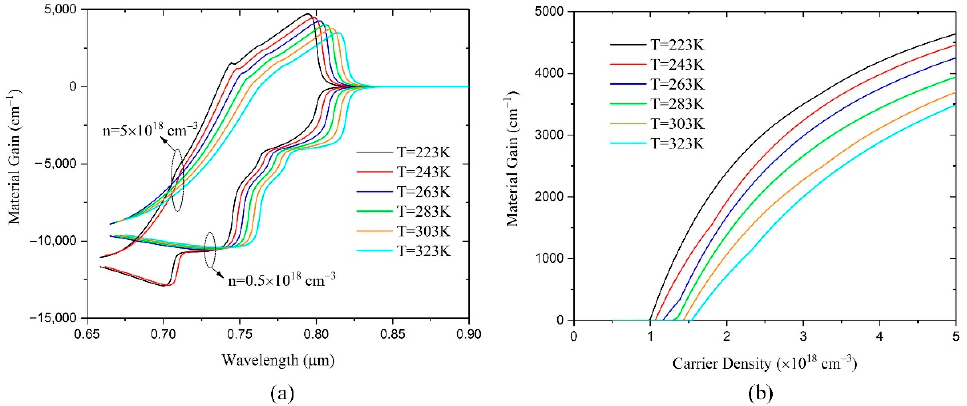
Figure 2. Temperature effects on material gain: ( a ) gain spectrum curves at different temperatures and injected carrier concentrations, ( b ) peak gain vs. injected carrier concentration at different tem- peratures.